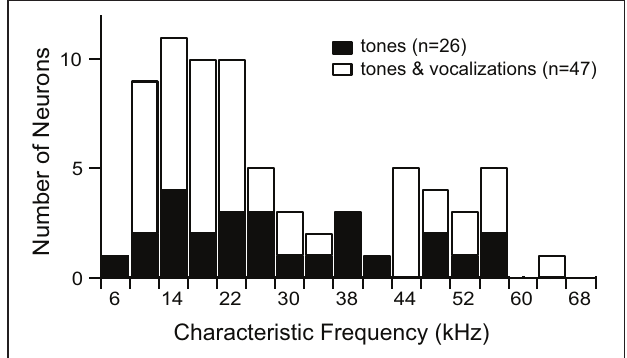
FIGURE 1 | Characteristic frequencies of single units presented with tones alone, or tones and